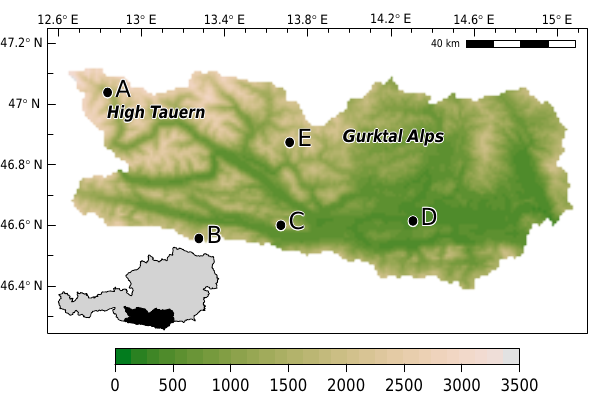
Figure 3. Empirical climatological probability of lightning for a day in July in Carinthia on the 1km × 1km scale computed from counting the days with lightning over all July days in the 6-year period and dividing by the number of all July